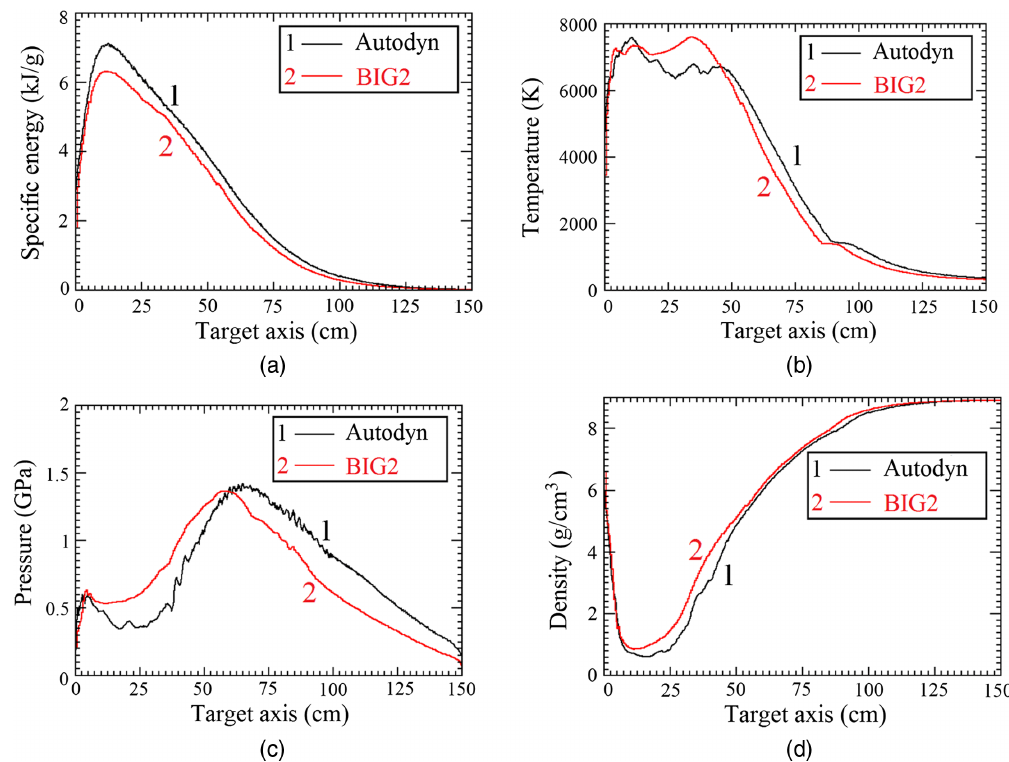
FIG. 12. Comparison between present simulations ( FLUKA and Autodyn) and previous simulations ( FLUKA and BIG 2 ), in terms of (a) accumulated specific energy, (b) temperature, (c) pressure, and (d) density along the target axis, just after the delivery of the entire beam of 144 bunches (at t ¼ 7 . 8 μ s).